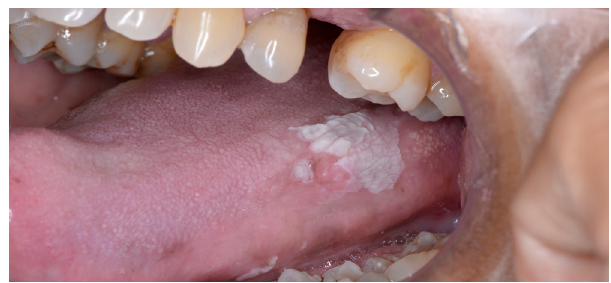
Fig. 1. Homogenous leukoplakia involving the left dorsal/lateral tongue (image provided by Guy ’ s and St Thomas ’ ).